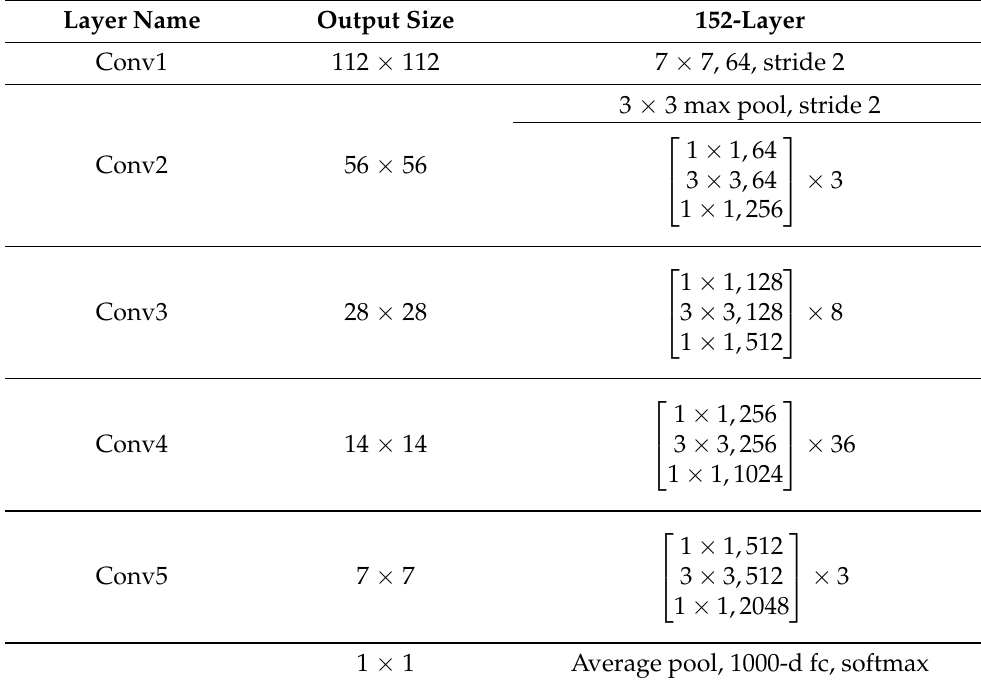
Figure 4. System overview. Table 1. Architecture of